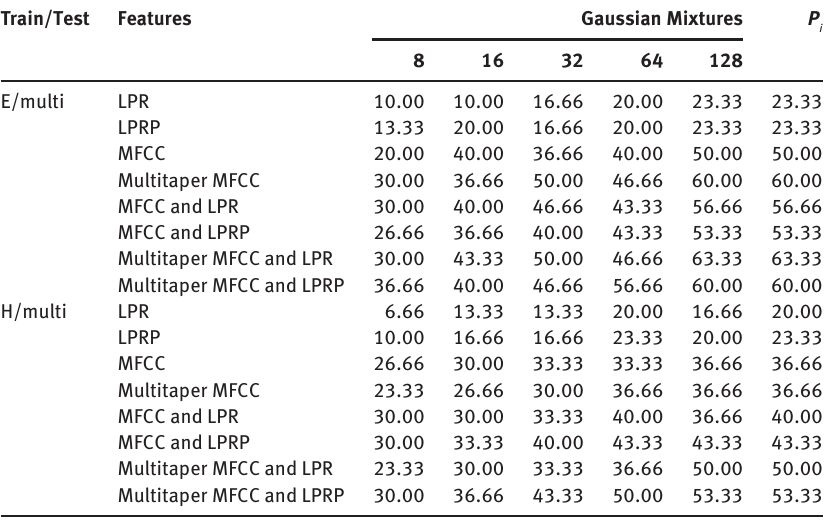
Table 3. The Multilingual Speaker Identification Performance using LPR, LPRP, MFCC, and Multitaper MFCC-Based Individual and Combined System. P cation Performance Among the Number of Gaussian